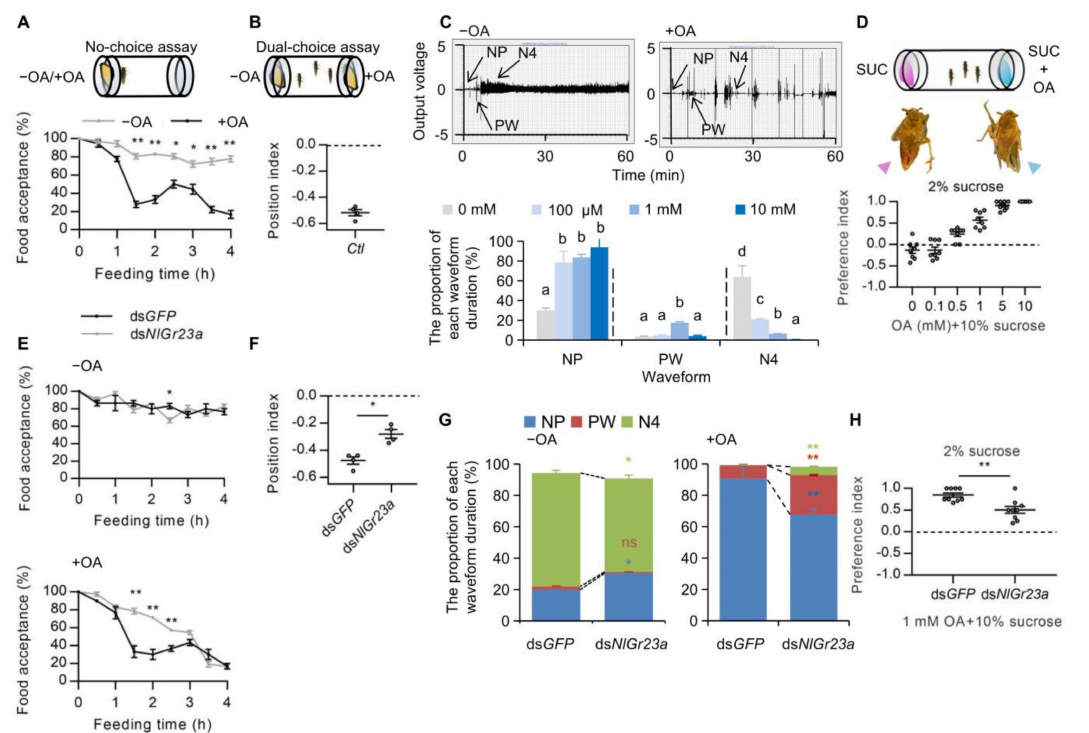
Figure 3. NlGr23a mediated the antifeedant activity of oxalic acid in artificial diets. ( A ) Top: Schematic representation of the experimental apparatus used for no-choice test. Bottom: The proportion of BPHs accepting artificial diets without ( − OA, in grey) or with 100 µ M OA (+OA, in black) as food in no-choice test. Bars represent means ± SEM. Mann–Whitney non-parametric test; * p < 0.05; ** p < 0.01 ( n = 3). ( B ) Top: Schematic representation of the experimental apparatus used for dual- choice test. Bottom: Collective data ( n = 4) of the PI values of the laboratory insects ( Ctl ) in response to food containing 100 µ M OA in dual-choice assays. Bars represent means ± SEM. ( C ) Top: Overall typical view of electrical penetration graph (EPG) waveforms generated by the feeding behaviors of the BPH on liquid diet sacs (LDS) without (left) or with (right) 100 µ M OA. There are three typical waveforms, including non-penetration (NP), pathway (PW), and ingestion (N4), which are indicted by arrows. Bottom: The duration of each EPG waveform as a proportion of observation time produced by BPHs on LDS containing artificial diets with different concentrations of OA. Bars represent means ± SEM. Different lowercase letters above columns represent significant differences at p < 0.05 from Duncan’s multiple range test ( n = 5). ( D ) Dose-responsive food choice assay for OA. Top: Schematic representation of the experimental apparatus used for food choice assay. Starved BPHs were introduced into a glass tube and provided with two choices (sucrose versus sucrose plus OA) colored with either red or blue dye. Bottom: Concentration-dependent avoidance of OA in BPHs. Bars represent means ± SEM ( n = 8). ( E ) Top: The proportion of insects accepting artificial food absent of OA ( − OA) among ds GFP -treated (black line) or ds NlGr23a- treated (grey line) BPHs in no-choice tests. Bottom: The proportion of insects accepting artificial food with 100 µ M OA (+OA) among ds GFP -treated or ds NlGr23a- treated BPHs in no-choice tests. Bars represent means ± SEM. Mann- Whitney non parametric test; * p < 0.05; ** p < 0.01 ( n = 3). ( F ) PI values of ds NlGr23a -treated and ds GFP -treated BPHs in response to +OA diets in dual-choice assays. Bars represent means ± SEM. Mann–Whitney non-parametric test; * p < 0.05 ( n = 4). ( G ) The duration of each EPG waveform as a proportion of observation time produced by ds GFP -treated and ds NlGr23a -treated BPHs on LDS with or without 10 mM OA. Stacked bar graphs represent means ± SEM. Mann–Whitney non-parametric test; ns means no statistical difference ( p >0.05); * p < 0.05; ** p < 0.01 ( n = 5). ( H ) Food choice assay for ds NlGr23a -treated and ds GFP -treated BPHs. 1 mM OA was mixed with 10% sucrose. Bars represent means ± SEM. Mann–Whitney non-parametric test; ** p < 0.01 ( n =